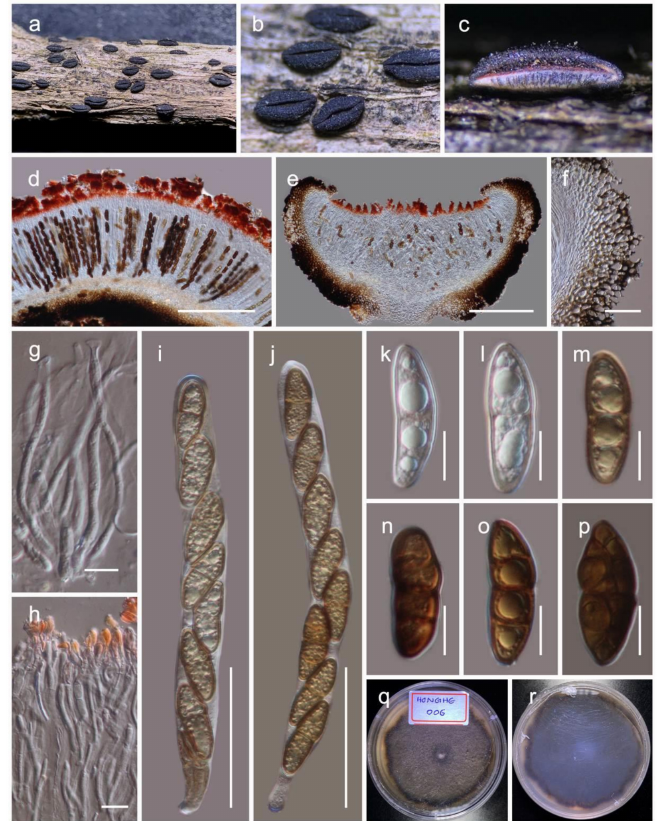
Figure 6. Rhytidhysteron hongheensis (HKAS110133, holotype). ( a,b ) Appearance of hysterothecia on the dead woody twigs of Dodonaea viscosa ; ( c,d ) horizontal section of hysteriothecium; ( e ) vertical section of hysteriothecium; ( f ) cells of peridium; ( g,h ) pseudoparaphyses; ( i,j ) asci; ( k – p ) ascospores; ( q,r ) colony on PDA ( r from the bottom). Scale bars, ( d,e ) 200 µ m; ( f,i,j ) 50 µ m; ( g,h , k – p ) 10 µ m. Culture characteristics: Colonies on PDA reached a 4 cm diameter after 2 weeks at 20 ◦ C. The colony was dense, circular, slightly raised, and the surface was smooth, with an undulated edge, with floccose which were greenish grey at the centre and brown towards margin from the top and reverse dark brown. The hyphae septate were branched, hyaline, thin, and